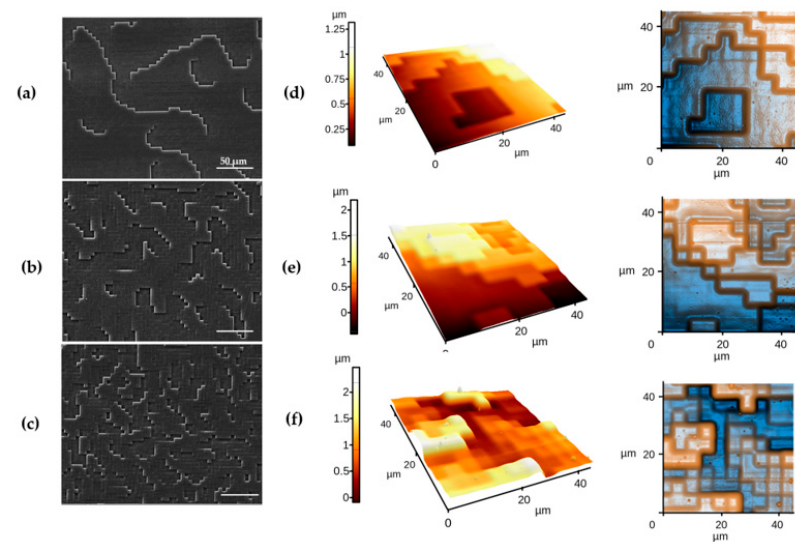
Figure 1. Scanning Electron Microscopy images of surface structures polydimethylsiloxane (PDMS) ( a ) Low-density square unit (LDSU), ( b ) Medium-density square unit (MDSU), and ( c ) High-density square unit (HDSU), with scale bar of 50 µm. Atomic Force Microscopy images of the PDMS structures of ( d ) LDSU, ( e ) MDSU, and ( f ) HDSU, respectively, with corresponding topographies in 3D and 2D representations combined with a synthetic illumination effect used to enhance the contour of each obtained slope.